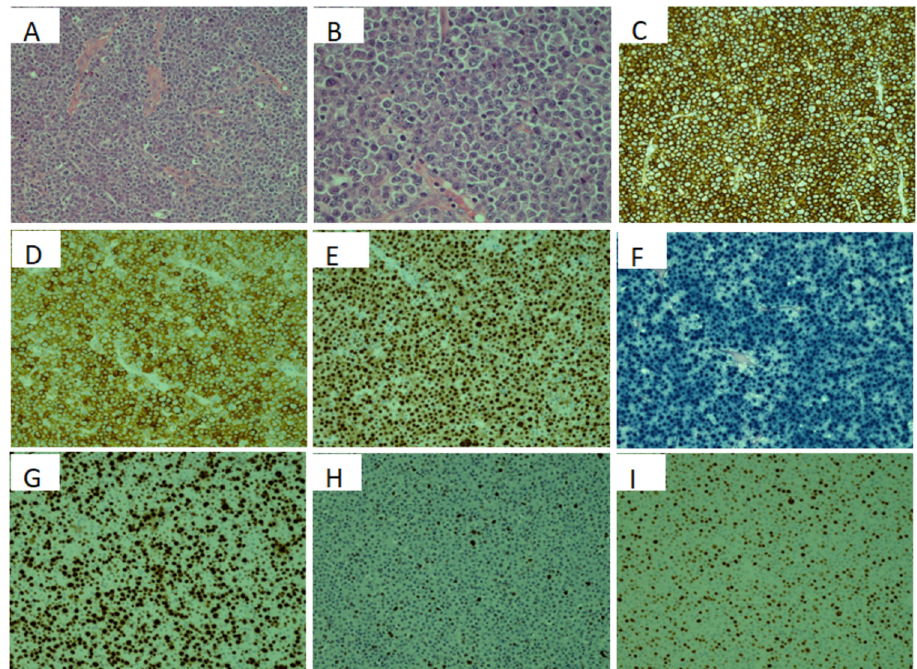
Figure 1. Histopathology pictures of left sinonasal mass: ( A , B ) Hematoxylin and Eosin stained slides (200× and 400×, respectively) of this mass lesion. ( C ) CD138 IHC shows diffuse positivity. ( D ) CD38 IHC shows diffuse positivity. ( E ) MUM1 IHC shows diffuse positivity. ( F ) EBV in-situ hybridization (EBER) shows diffuse RNA positivity. ( G ) Ki67 IHC shows 70% proliferation index. ( H ) P53 IHC shows rare positivity (5%). ( I ) c-MYC IHC shows nearly 50% positive